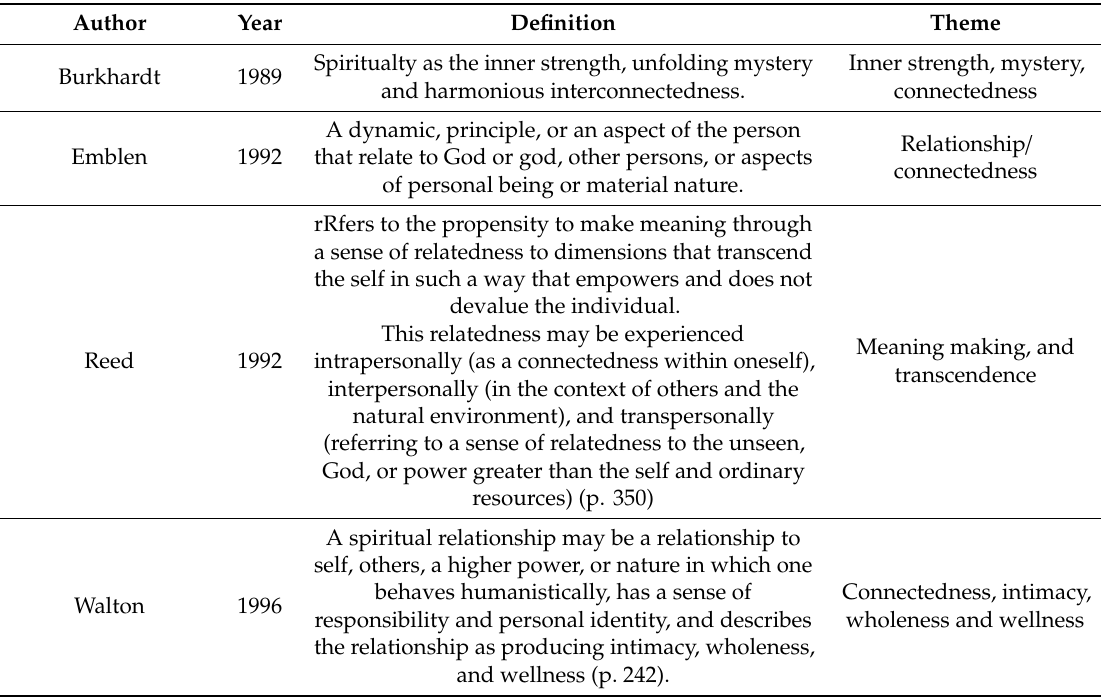
Table 1. Definitions of spirituality and underlying